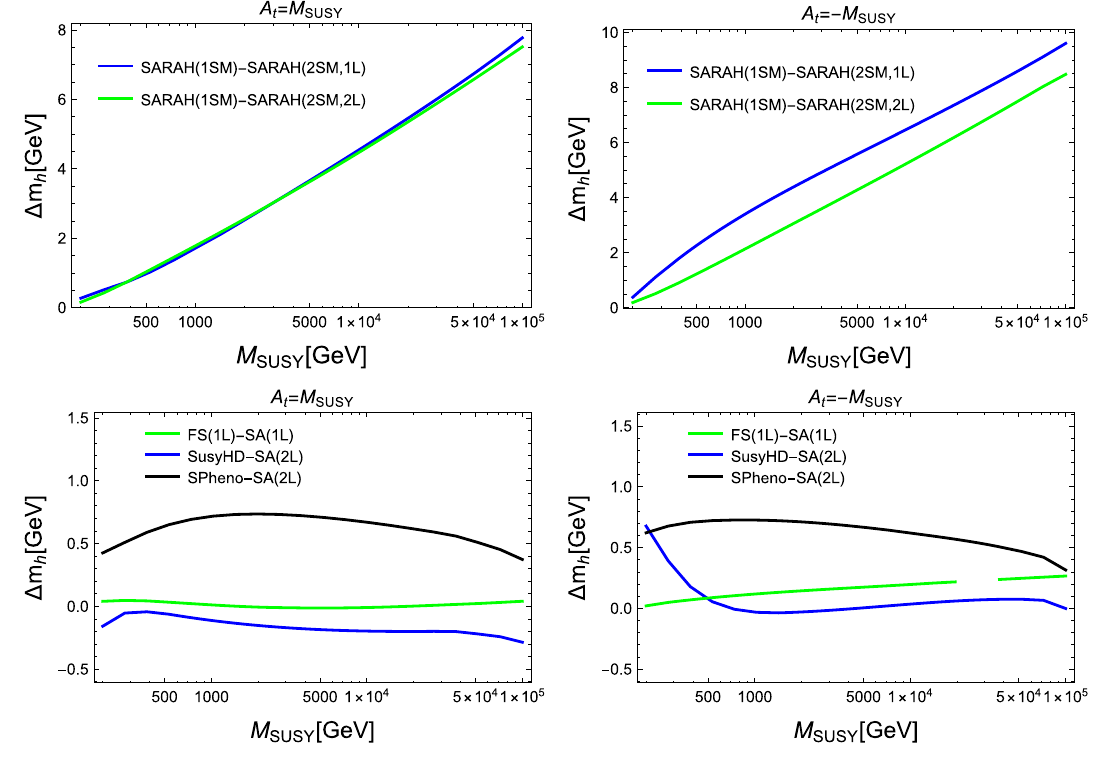
Fig. 10 The same as Fig. 9 for non-vanishing A t SUSY scales, while the difference from the other codes is in the range of 1 GeV and